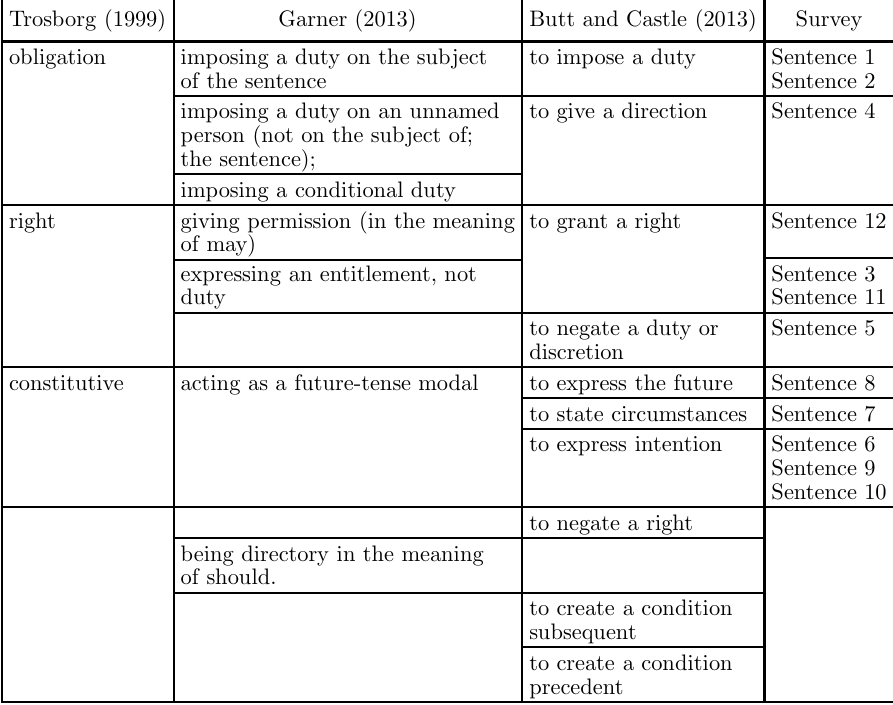
Meanings of shall identified by different authors Trosborg